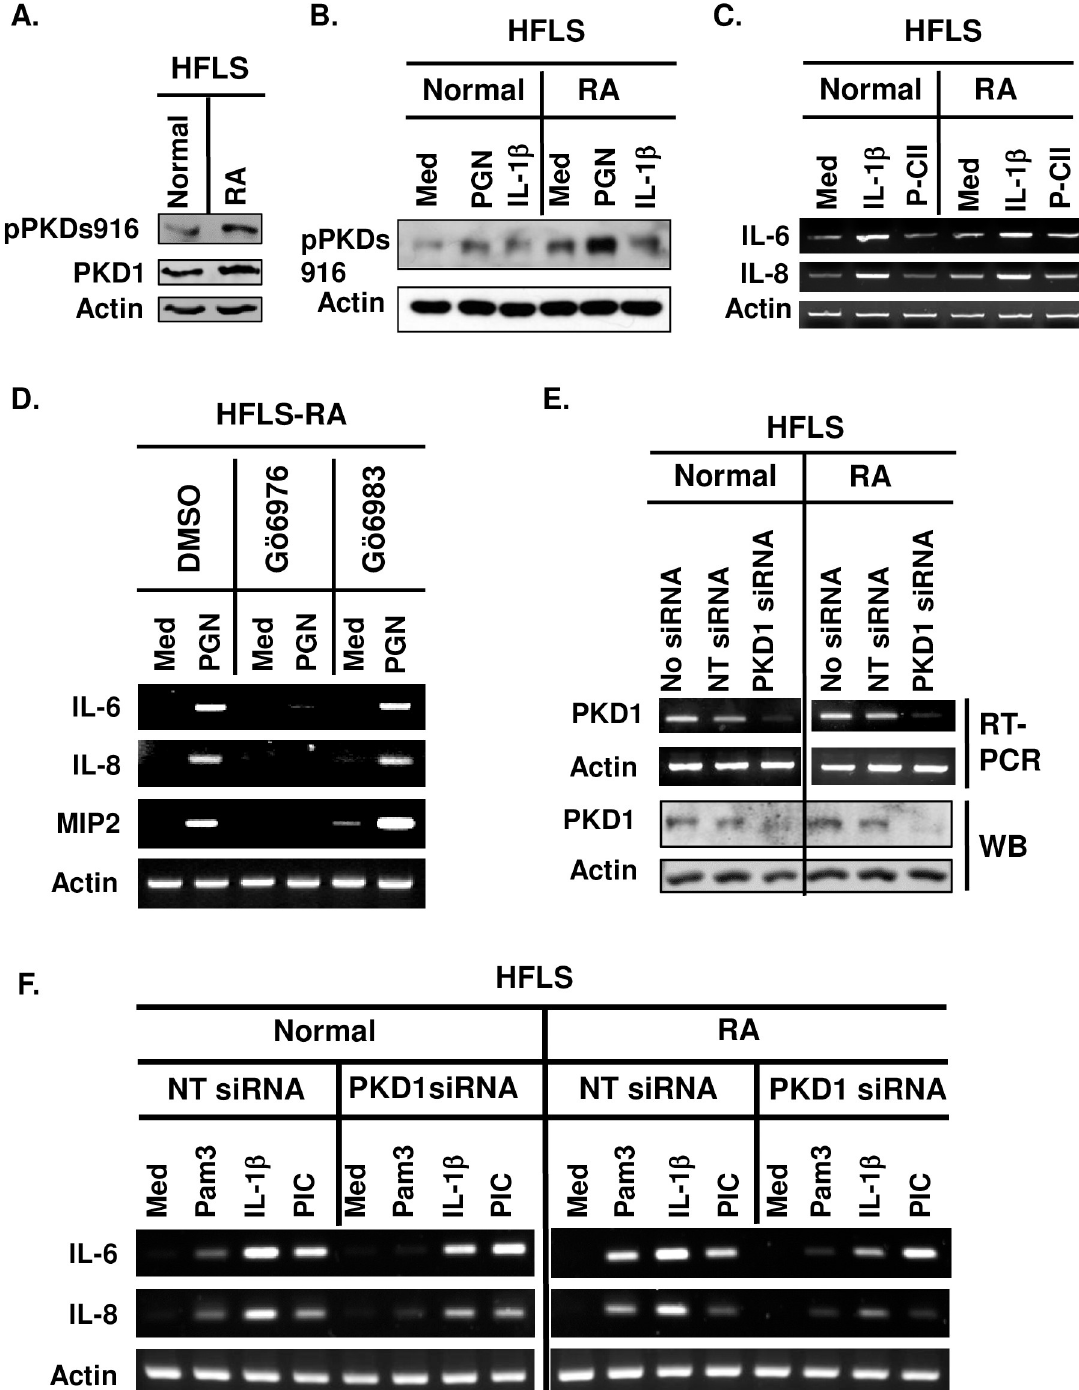
Fig 1. PKD1 can be activated and plays an essential role in both spontaneous and TLR/IL-1R-induced expression of proinflammatory mediators in human synoviocytes. (A) Protein levels and phosphorylation status of PKD in human primary fibroblast-like synoviocytes (HFLS) from a normal donor (HFLS-N) and from a patient with RA (HFLS-RA) were detected by Western blot. (B) HFLS-N and HFLS-RA were stimulated with media (med), TLR2 ligand peptidoglycan (PGN; 50 μ g/ml), or human recombinant IL-1 β (10 ng/ml) for 45 min. Protein levels and phosphorylation status of PKD were detected by Western blot. (C) HFLS-N and HFLS-RA were stimulated with media (med), IL-1 β (10 ng/ml), or synthetic CII peptide (P-CII; 50 μ g/ml) for 4 hr. Levels of IL-6 and IL-8 mRNA were analyzed by RT-PCR. (D) HFLS-RA were pretreated with vehicle (1% v/v DMSO), Go¨6976 (500 ng/ml) or Go¨6983